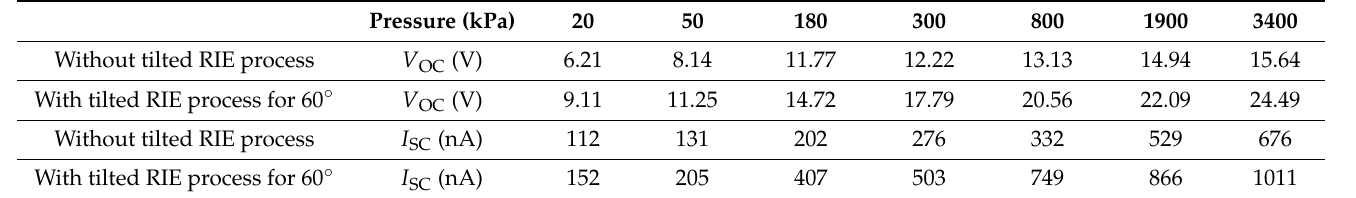
Table 3. Each electrical output generated from TSR-B and TSR-T60 according to the applied